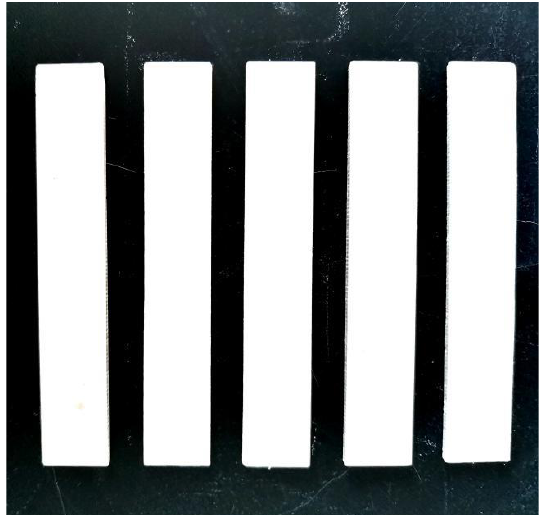
Figure 2. The image of the laboratory specimens